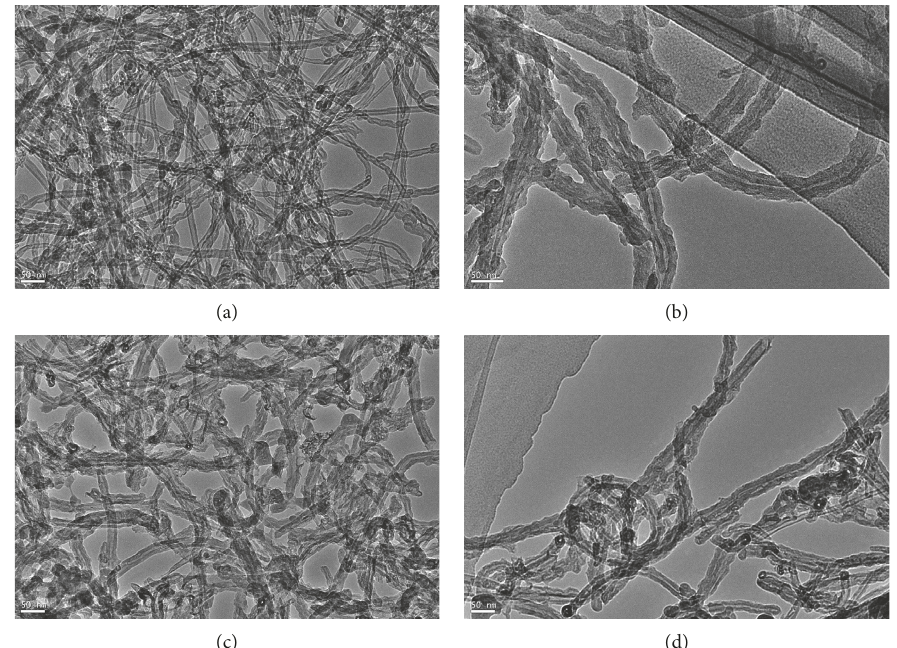
Figure 3: TEM of the samples: (a) carboxylic MWCNTs; (b) CNTs-Pdop-S(CF is